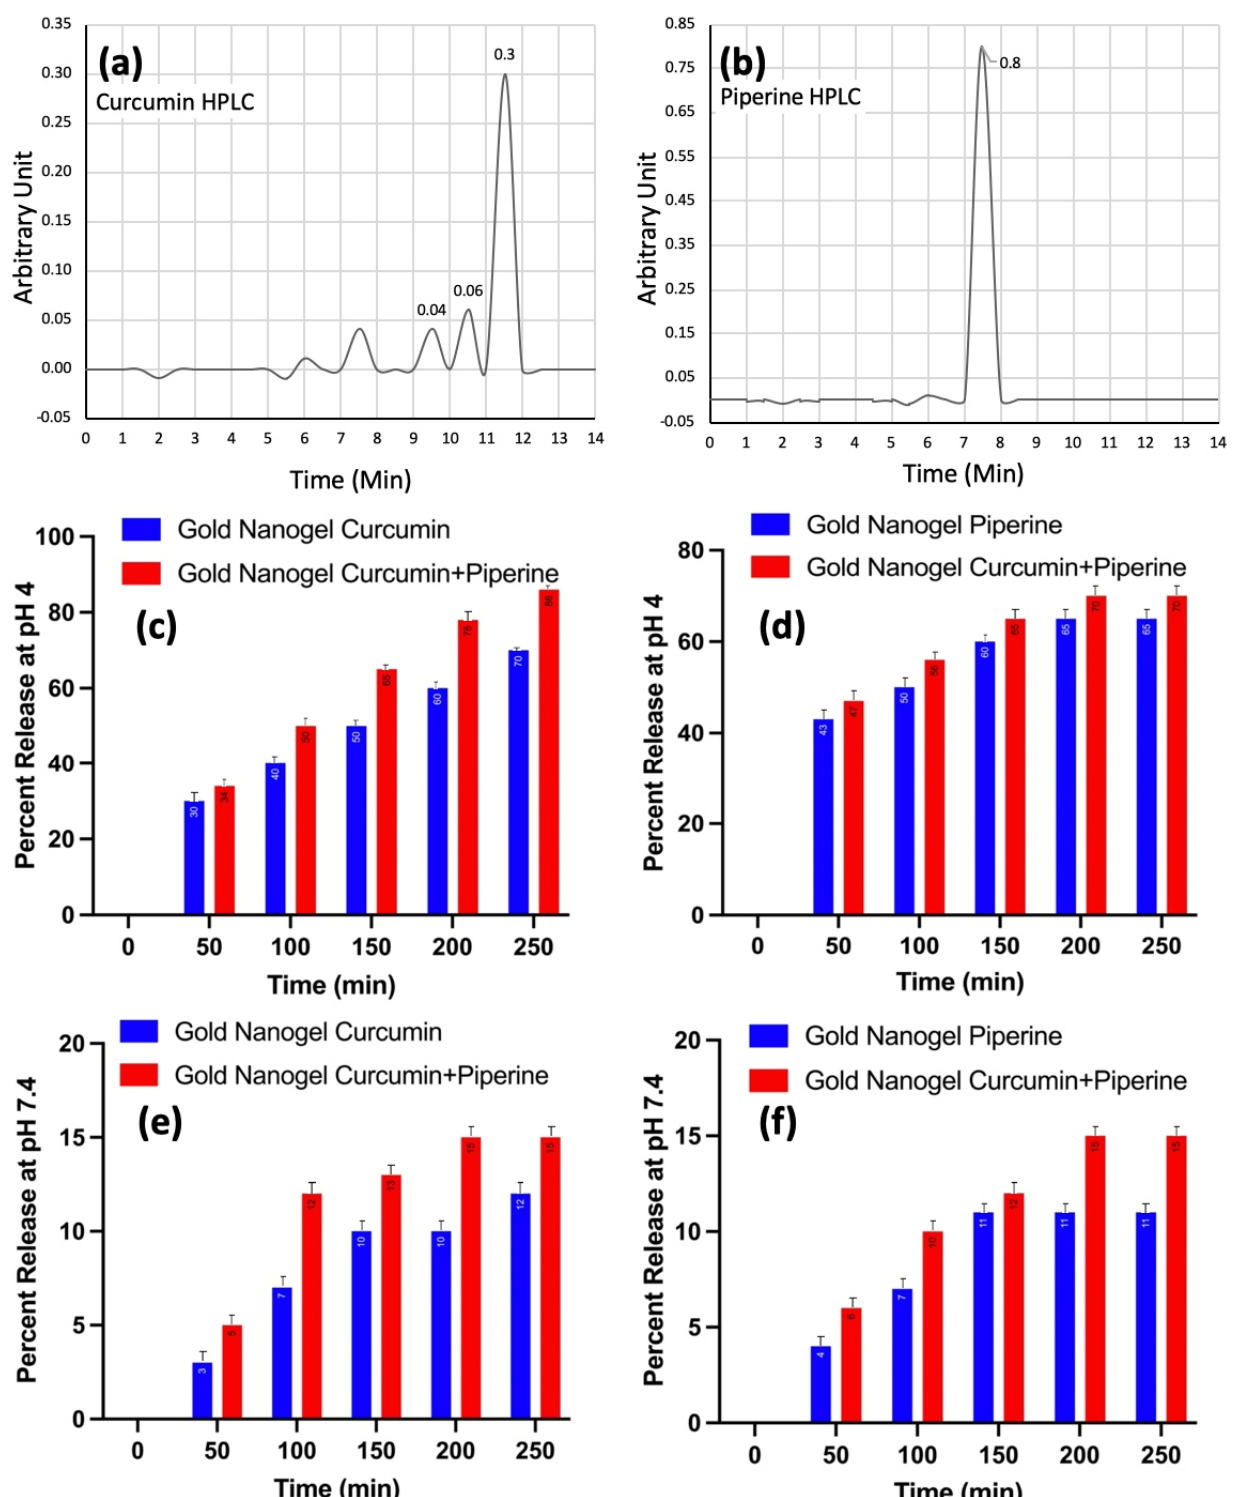
Figure 3. Determination of drug release kinetics; ( a ) curcumin HPLC; ( b ) piperine HPLC; ( c ) kinetic release of curcumin from nanogels at pH 4; ( d ) kinetic release of piperine from nanogels at pH 4; ( e ) kinetic release of curcumin from nanogels at pH 7.4; ( f ) kinetic release of piperine from nanogels at pH 7.4. Figure 4 represents the percentage cell viability of the U-251 MG glioblastoma cells treated with piperine and curcumin. The cell viabilities higher than 100% are presumed